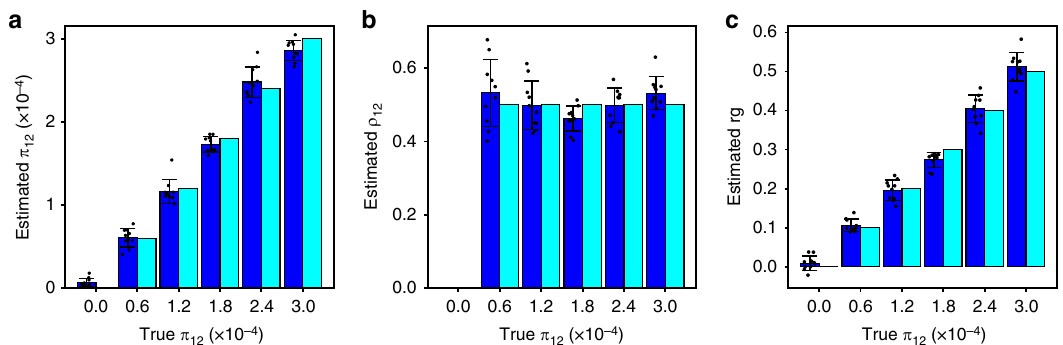
Fig. 2 Selected simulations with bivariate model: a the estimates of polygenic overlap; b the estimates of correlation of the effect sizes in shared polygenic component; c the estimates of genetic correlation. The bars in blue indicate an average value of model estimates across ten simulation runs. The bars in cyan show true (simulated) parameters. Error bars represent standard deviation of the model estimate across ten simulation runs. Individual simulation runs are shown as dot points. Different bars correspond to levels of polygenic overlap: from zero (no overlap) to complete polygenic overlap. Simulated heritability is 0.4, simulated fraction of causal variants is 0.03% in